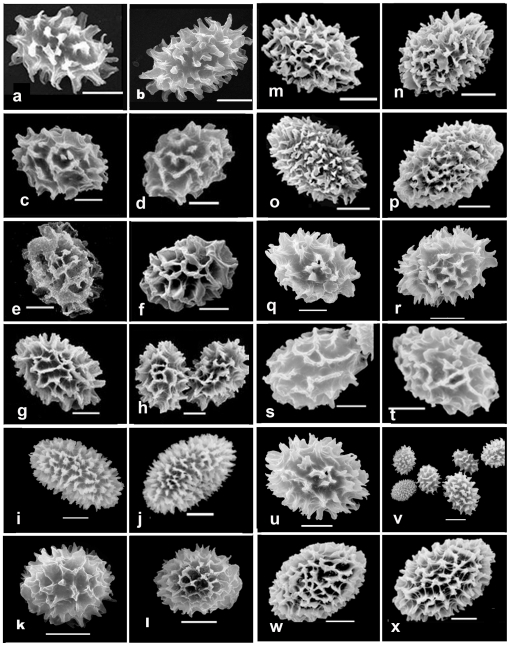
SEM of Tuber species ascospores, showing the detail of ornamentation.a–b. T. indicum
Holotype K(M)39493; c–d. T. sinense
Isotype HMAS60222; e–f. T. himalayense
Isotype K(M)32236; g–h. T. formosanum KUN-HKAS49707; i–j. T. melanosporum KUN-HKAS52034; k–l. T. pseudohimalayense
Isotype AH18331; m–n. T. indicum KUN-HKAS29357; o–p. T. indicum KUN-HKAS30261; q–r. T. indicum KUN-HKAS52030; s–t. T. indicum KUN-HKAS44330; u–v. T. indicum KUM-HKAS44988; w–x. T. indicum KUN-HKAS41312.